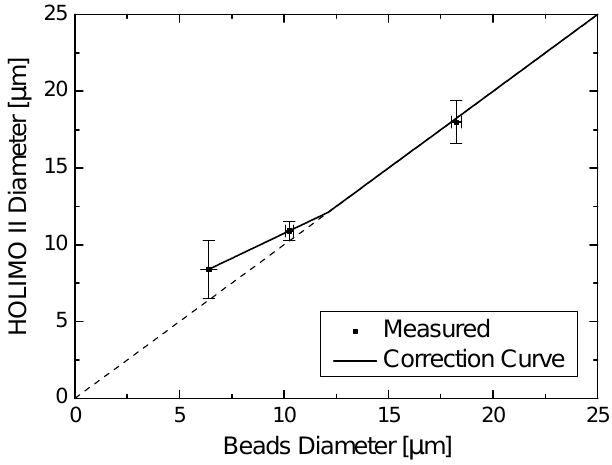
Fig. 5. HOLIMO II size measurements versus the accurate (manufacturer-supplied) sizes of monodispersed spheres and the correction curve applied to HOLIMO II data.